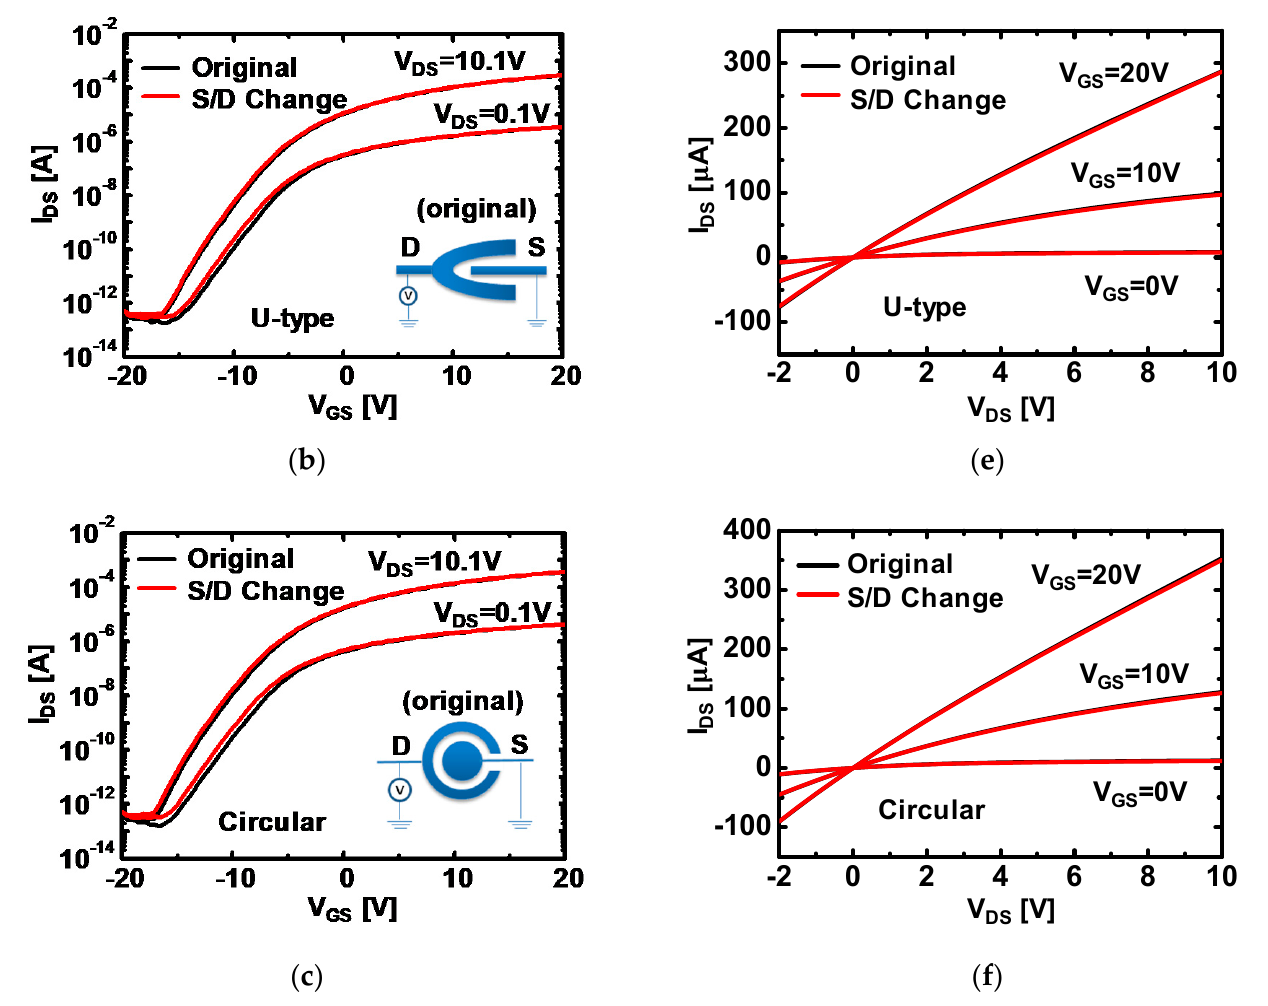
Figure 2. Transfer characteristics of ( a ) zigzag, ( b ) U-type, and ( c ) circular-type a-IGZO TFTs depending on bias configuration. The original is the bias configuration as shown in the insect. Source and drain (S/D) change is a reversed S/D configuration for the same bias value. Output characteristics, corresponding to each channel shape of ( c ) zigzag, ( d ) U-type, and ( e ) circular-type a-IGZO TFTs according to bias configuration. The channel width and length for a-IGZO is 200 and 4 µm, respectively.